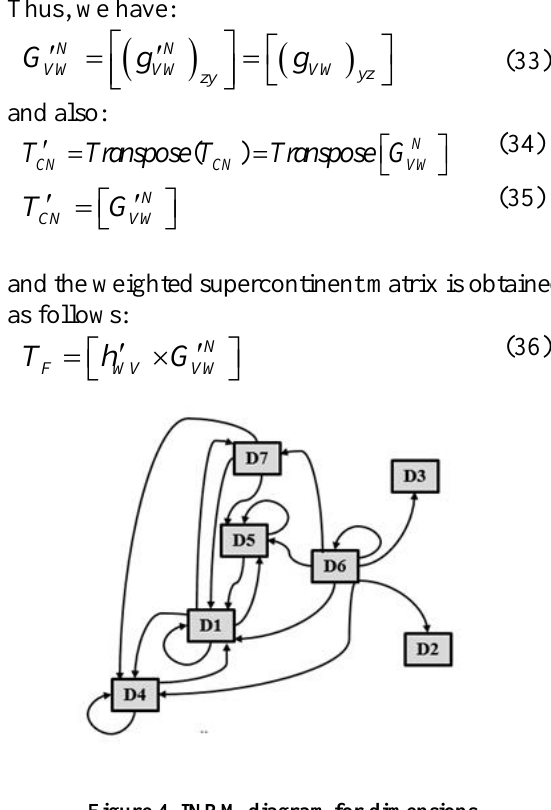
Figure 4. INRM diagram for